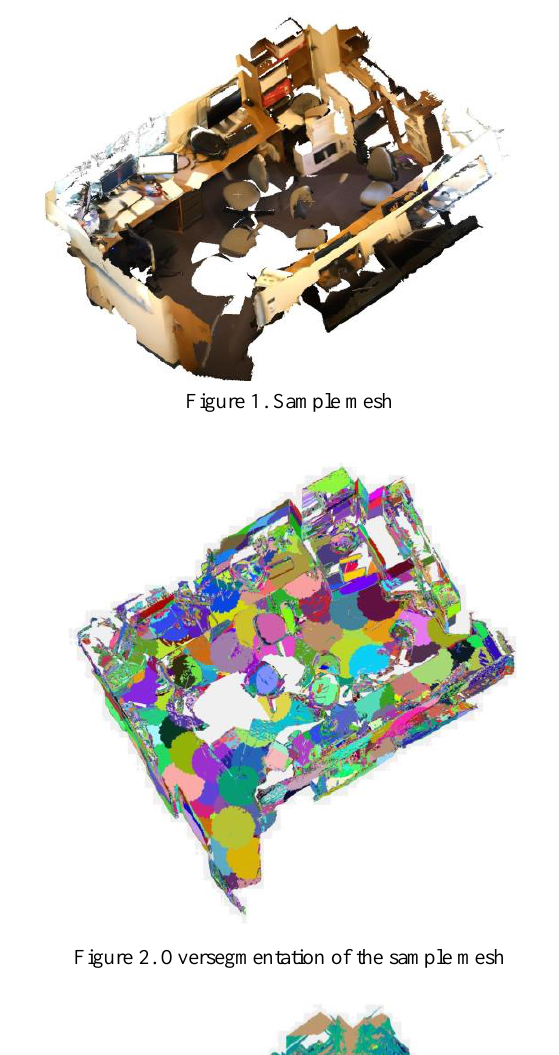
Figure 2. Oversegmentation of the sample mesh